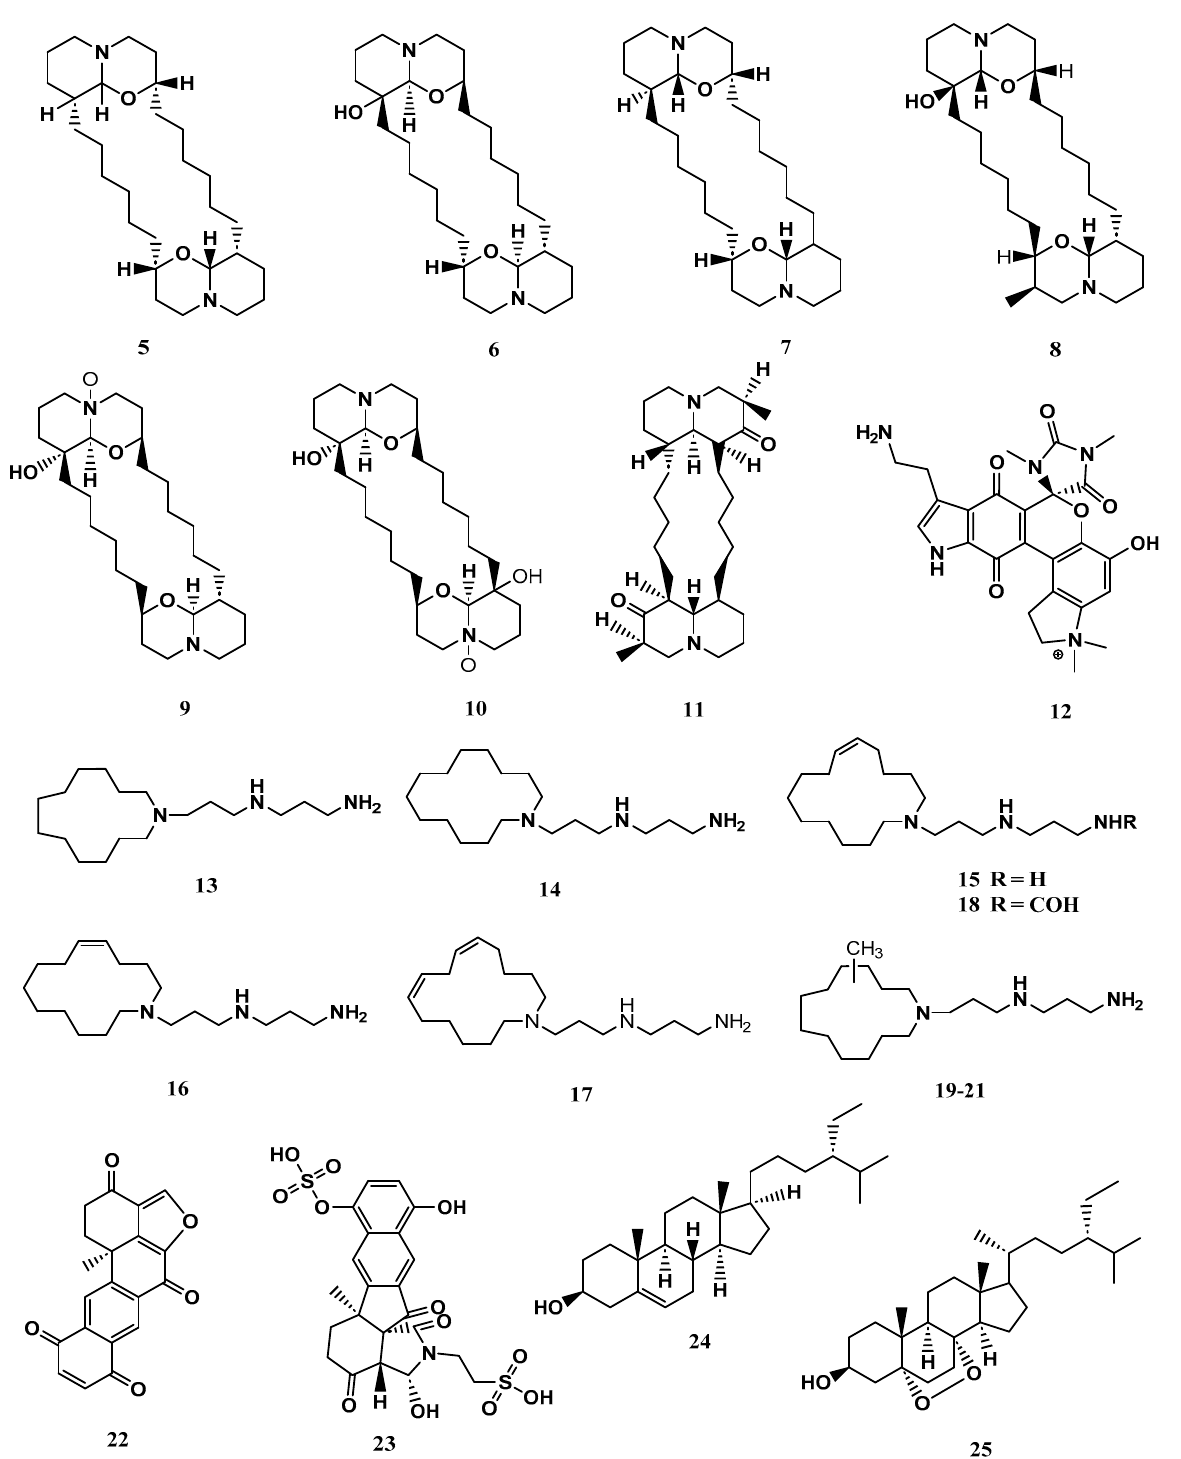
Figure 6. The chemical structures of compounds isolated from Xestospongia exigua ( 5 - 25 ).